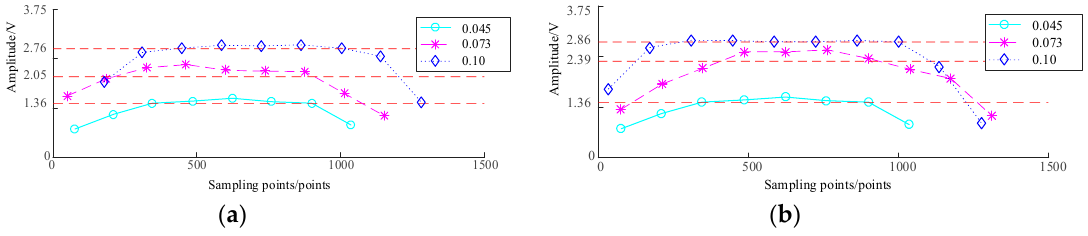
Figure 8. The peak of flaw signal with di ff erent depths (( a ) The peak of inner flaw signal with di ff erent depths; ( b ) The peak of outer flaw signal with di ff erent